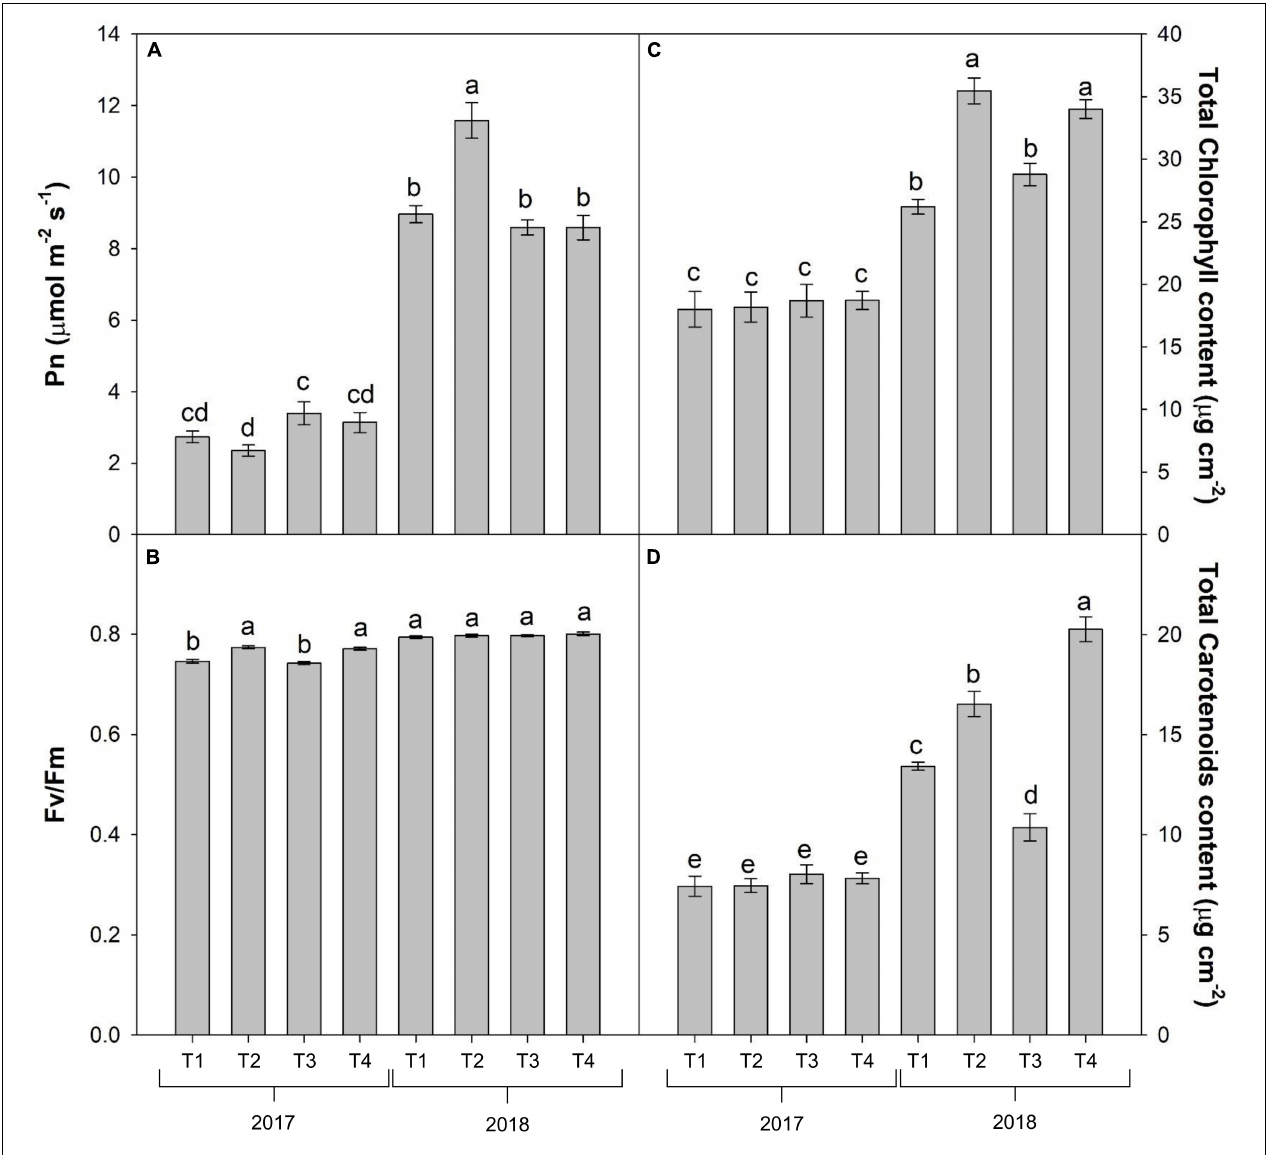
FIGURE 4 | Combined effects of year and foliar treatments on net photosynthetic rate ( P n ) (A) , maximum quantum efficiency of PSII photochemistry ( F v / F m ) (B) , total chlorophyll content (C) and total carotenoids content (D) of V. vinifera “Aglianico” vines (mean ± SE). Different letters indicate significant differences according to Duncan’s multiple-range test ( P ≤ 0.05). [T1 – only industry water mixture of copper oxychloride; T2 – industry water mixture of copper oxychloride plus Trym R (cid:13) ; T3 – half dose of copper oxychloride water mixture; T4 – half dose of copper oxychloride water mixture plus Trym R (cid:13)